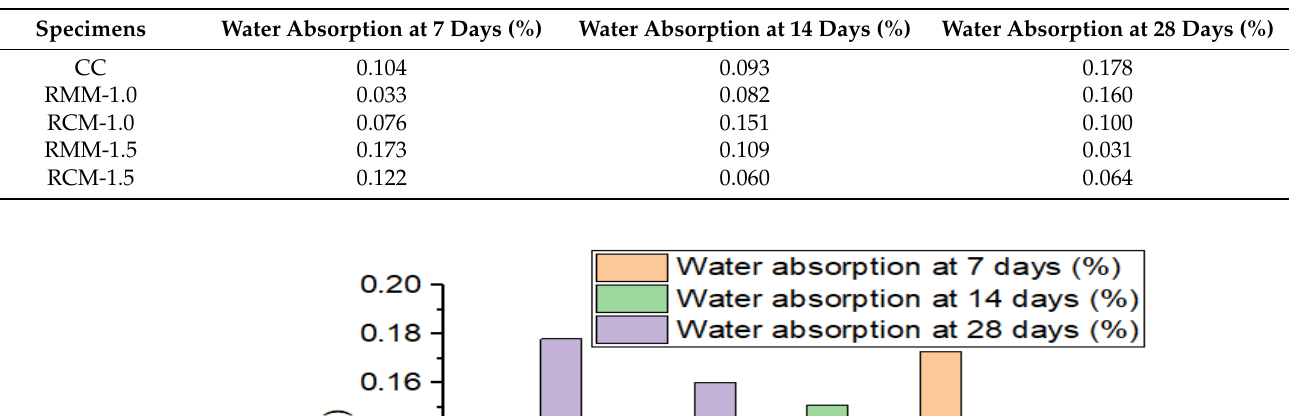
Table 4. Water absorption test results.